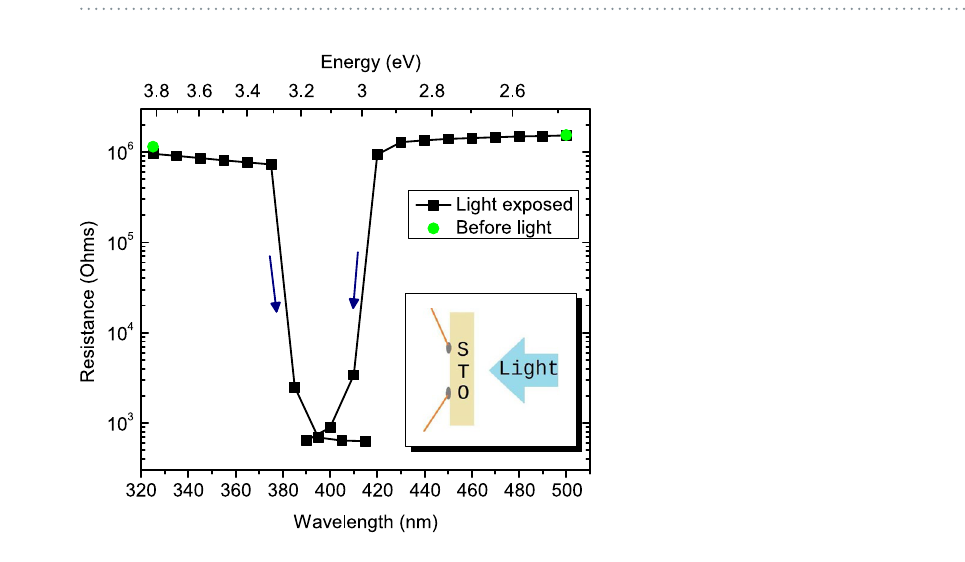
Figure 2. Two-point resistance versus wavelength of light for two STO samples. The duration of light exposure was 10 s at each wavelength. Arrows indicate whether wavelengths were increased or decreased sequentially. Inset: Schematic diagram of the setup. Contacts were placed on the side opposite to light